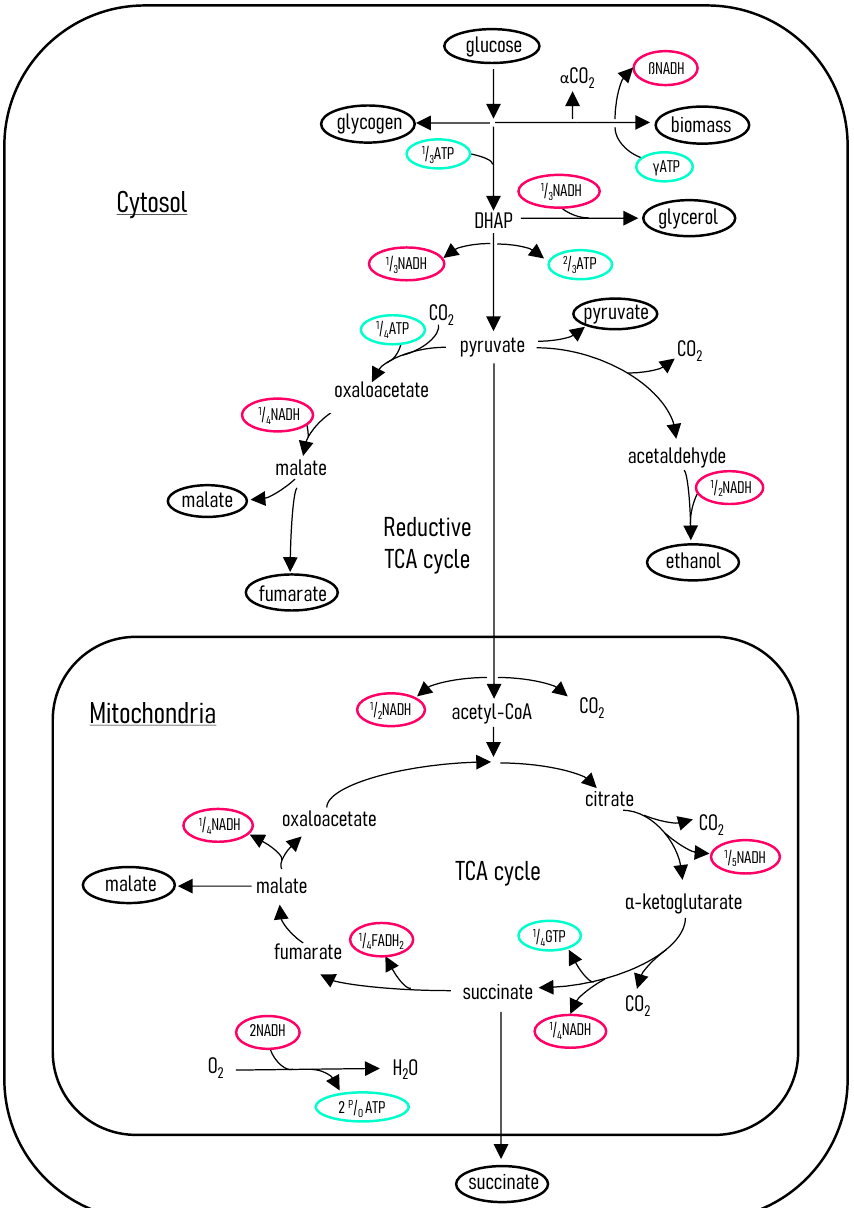
Figure 5. R. oryzae metabolic flux model. The flux model is written on the basis of carbon moles; this results in the fractional amounts of the energy-related compounds. The compounds that interact with the medium are circled in